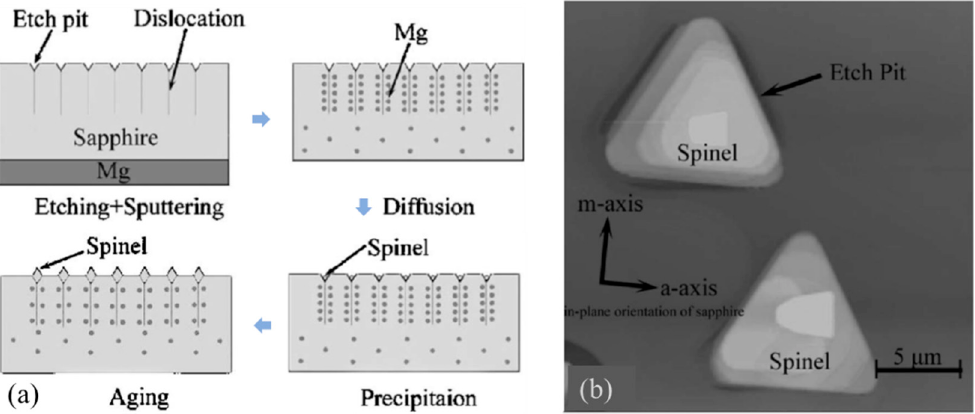
Figure 7. Schematic diagram of the fabrication process ( a ) and the as-fabricated spinels ( b ) [136]. Reproduced with permission from AIP Publishing. Reproduced with permission from AIP